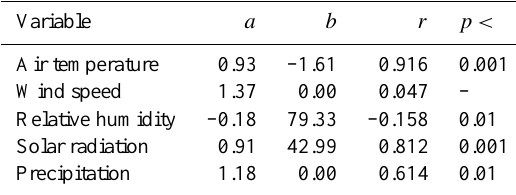
Table 1. Parameters for estimating daily meteorological variables ( y) at the summit of the Gregoriev Glacier by linear regression ( y = ax + b) from variables of reanalysis datasets ( x) . Air temper- ature and precipitation are preliminarily modified for the Tien Shan station (see Sect. 2.4). Also listed is the correlation coefficient ( r) and its significance level ( p) . Regression equations for wind speed and precipitation are obtained by assuming a zero intercept ( b = 0 ) to avoid negative wind speed and persistent